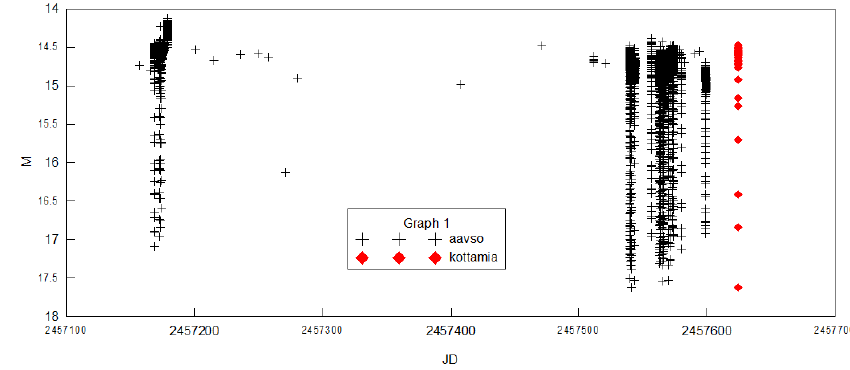
Fig. 6 Our CCD photometric observations in comparison with that collected from the AAVSO data base for DQ Her.